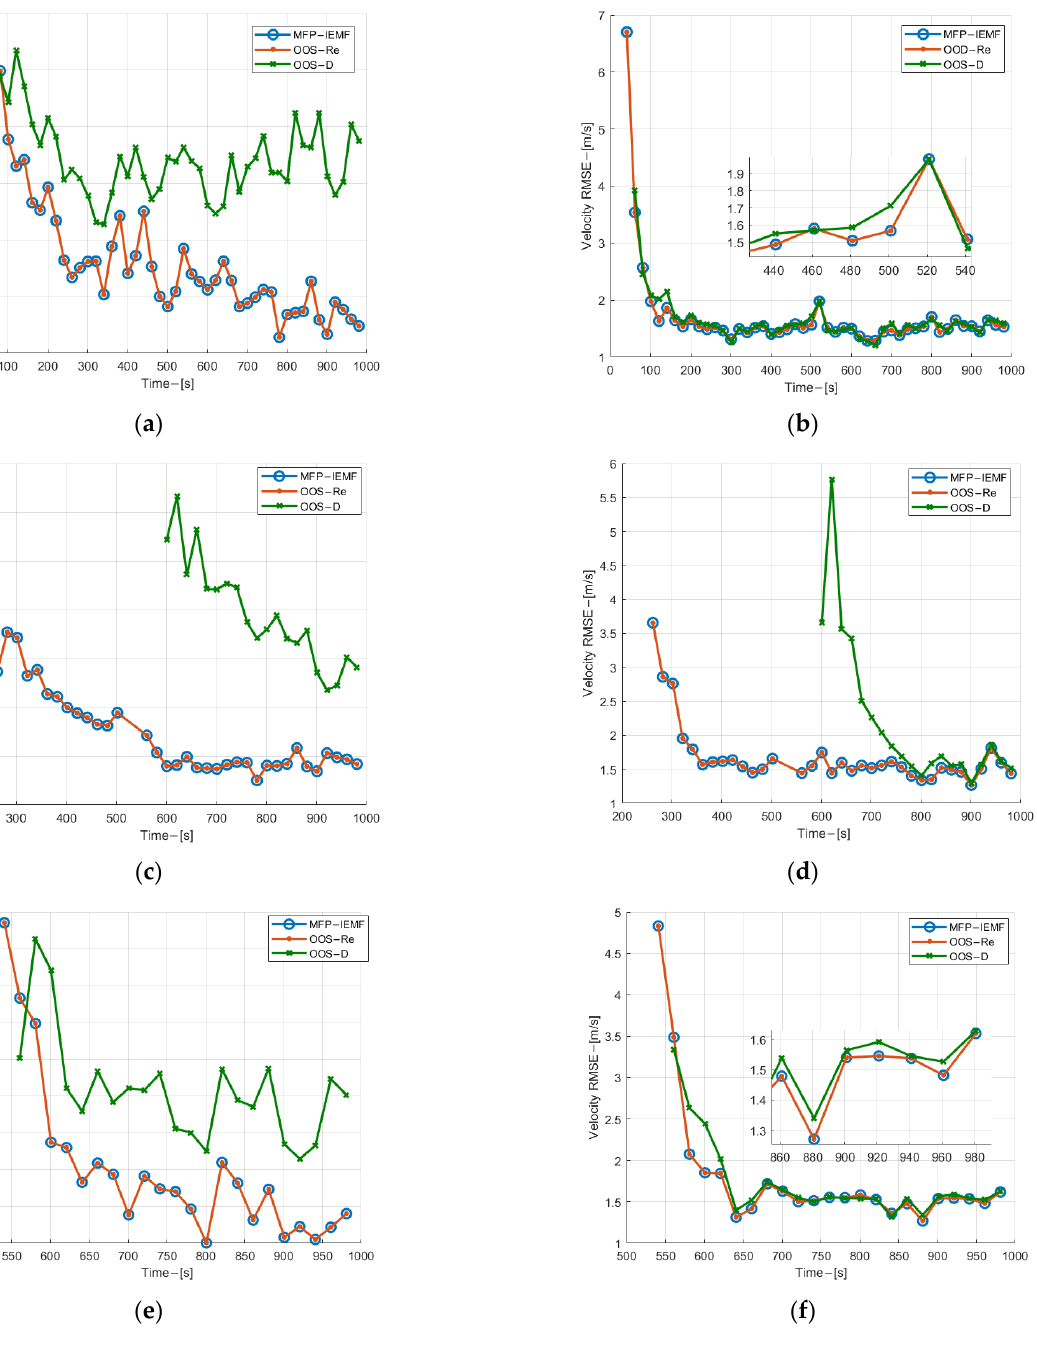
Figure 8. ( a ) Position estimation RMSE of submarine 1 in experiment 2; ( b ) velocity estimation RMSE for submarine 1 in experiment 2; ( c ) position estimation RMSE of submarine 2 in experiment 2; ( d ) velocity estimation RMSE for submarine 2 in experiment 2; ( e ) position estimation RMSE of submarine 3 in experiment 2; ( f ) velocity estimation RMSE for submarine 3 in experiment 2.